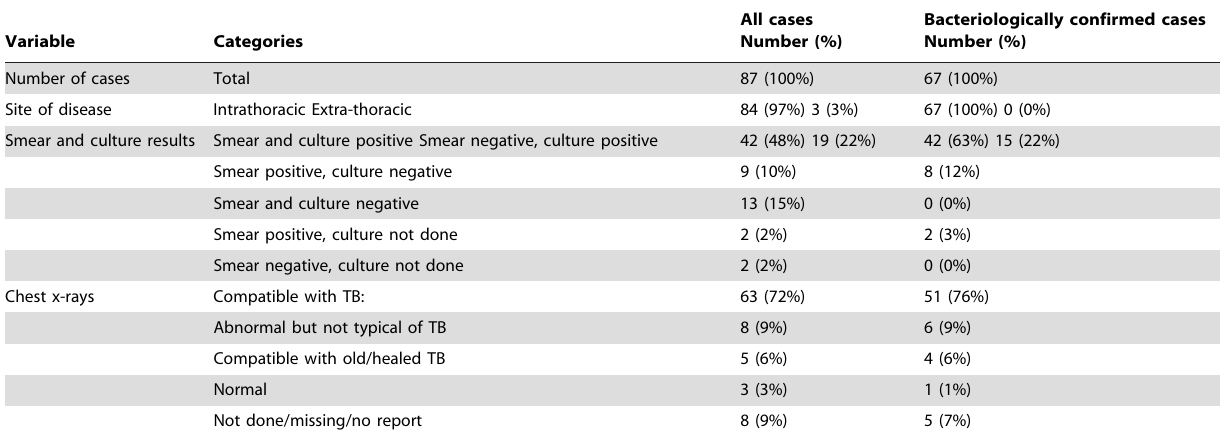
Table 2. Profile of TB incident cases.